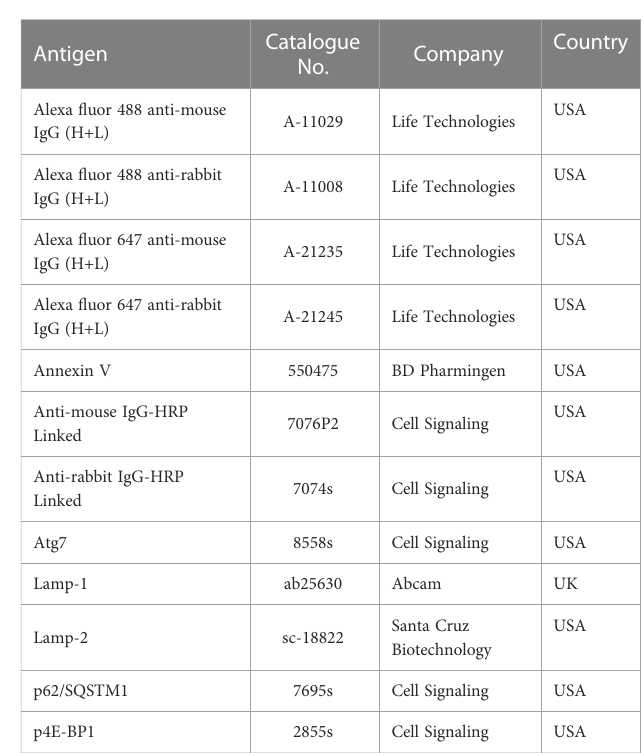
TABLE 3 List of antibodies used in